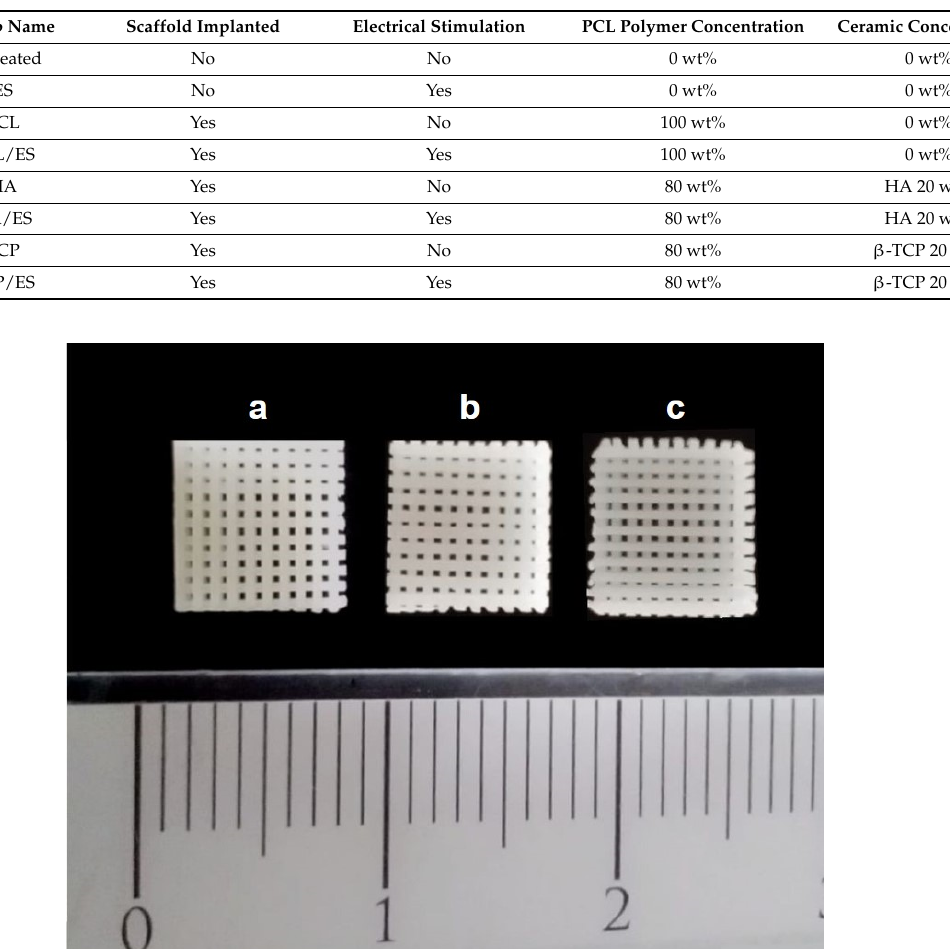
Figure 1. Three ‐ dimensional scaffolds produced by additive manufacturing (5 mm × 5 mm × 2 mm) before implantation into the bone defects. ( a ) PCL scaffold, ( b ) PCL with HA scaffold, and ( c ) PCL with TCP scaffold (unit: centimeter). Table 1. Experimental groups for in vivo study.